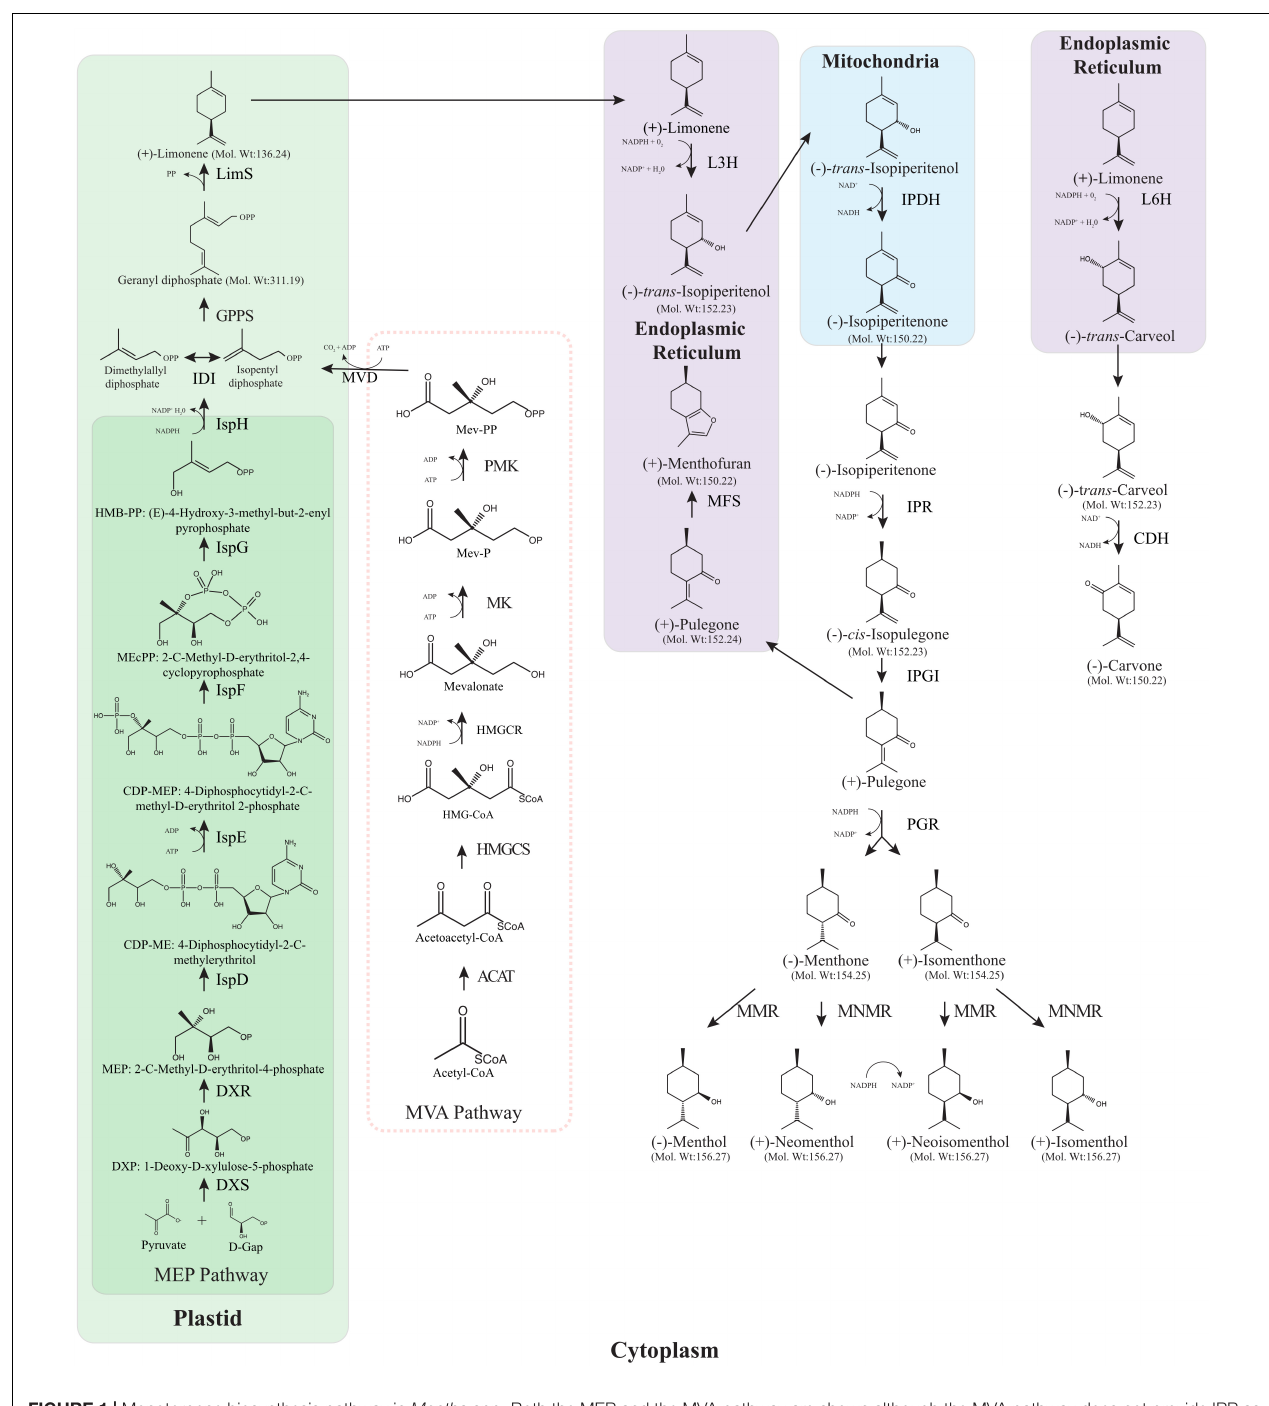
FIGURE 1 | Monoterpene biosynthesis pathway in Mentha spp. Both the MEP and the MVA pathway are shown although the MVA pathway does not provide IPP as it is blocked in peppermint trichomes. ACAT, acetyl-coenzyme A acetyltransferases (Thiolase); HMGCS, hydroxymethylglutaryl-CoA synthase; HMGCR, 3-hydroxy-3-methylglutaryl-coenzyme A reductase; MK, mevalonate kinase; PMK, phosphomevalonate kinase; MCD, mevalonate diphosphate decarboxylase; DXS, 1-deoxy-D-xylulose 5-phosphate synthase; DXR, 1-deoxy-D-xylulose 5-phosphate reductoisomerase; IspD, 2-C-methyl-D-erythritol 4-phosphate cytidylyltransferase; IspE, 4-(cytidine 5 (cid:48) -diphospho)-2-C-methyl-D-erythritol kinase; IspF, 2-C-methyl-D-erythritol 2,4-cyclodiphosphate synthase; IspG, 4-hydroxy-3-methylbut-2-en-1-yl diphosphate synthase; IspH, 4-hydroxy-3-methylbut-2-enyl diphosphate reductase; IDI, isopentenyl diphosphate isomerase; GPPS, geranyl diphosphate synthase; LimS, (–)-limonene synthase; L3H, (–)-4S-limonene-3-hydroxylase; IPDH, (–)- trans -isopiperitenol dehydrogenase; IPR, (–)- trans -isopiperitenone reductase; IPGI, (+)- cis -isopulegone isomerase; PGR, (+)-pulegone reductase; MFS:(+)-menthofuran synthase; MMR, (–)-menthone: (–)-menthol reductase; MNMR, (–)-menthone: (–)-neomenthol reductase; L6H, (–)-4S-limonene-6-hydroxylase; CDH, (+)- trans -carveol dehydrogenase. The absolute stereochemistry, corresponding to the optical rotation signs, is provided structurally.